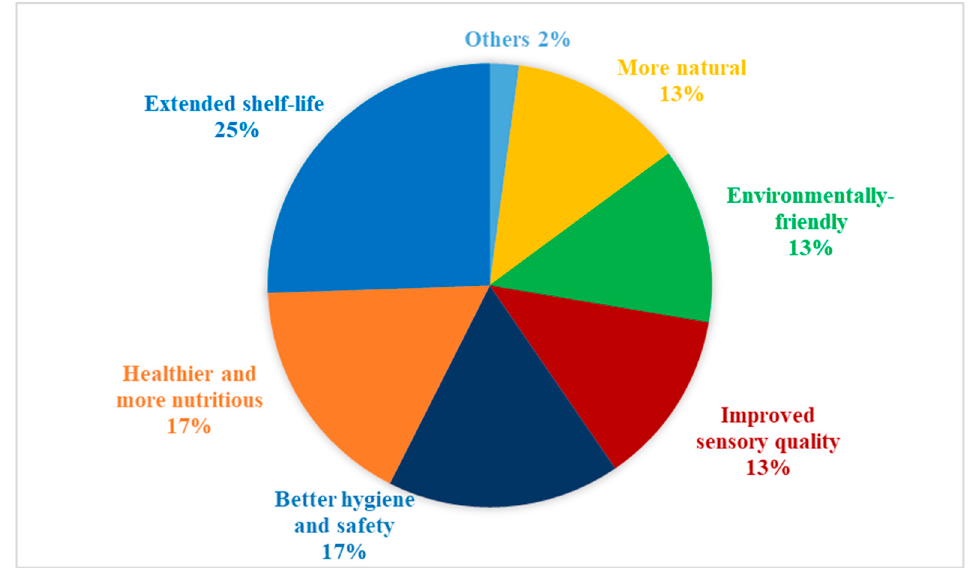
Figure 3. Frequency distribution of participants’ expected benefits of NTP and NTP processed F&V. Participants expected non-thermally processed F&Vs could be healthier and more nutritious